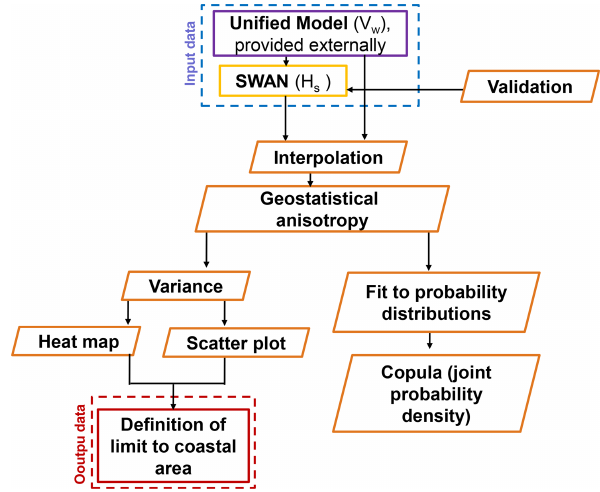
Figure 3. Flow chart summarizing the methodology used in this pa- per. The dashed blue rectangle represents the input data, and the dashed red rectangle indicates the output data. The wind velocity is obtained from an external source, and it was validated in Martin et al. (2006). The rest of the steps have been carried out for this anal- ysis. Rectangles indicate data generation (input/output), and rhom- buses indicate the subsequent analyses of the proposed methodol-